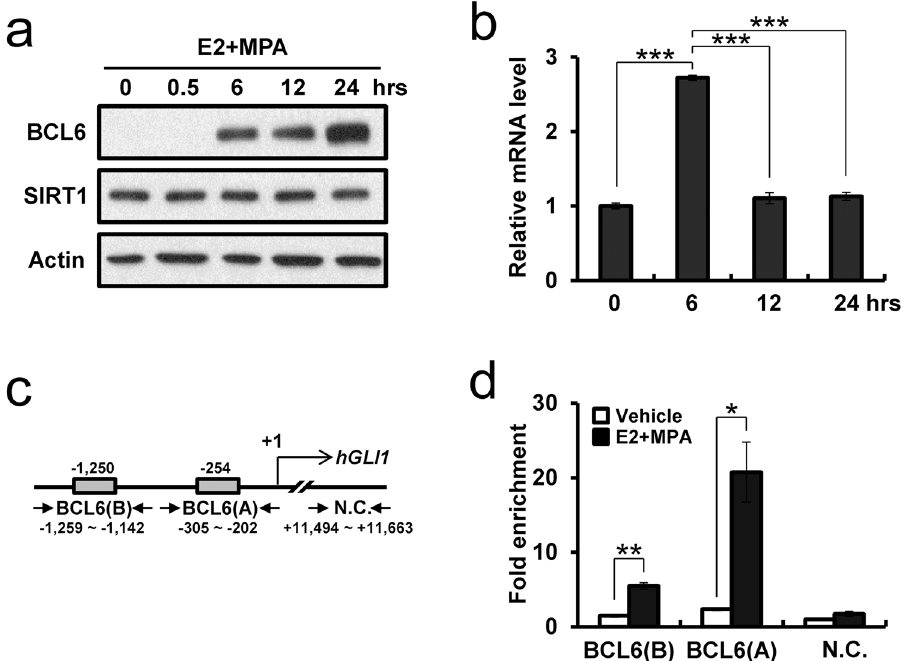
Figure 6. Regulation of GLI1 gene expression by SIRT1 and BCL6 proteins. ( a ) Western blot analysis of BCL6 and SIRT1 in Ishikawa cells treated with E2 + MPA for 0, 30 min, 6, 12, and 24 hours. β -actin was used as sample-loading control. Representative blots have been cropped to reduce unnecessary area. Full-length blots are presented in Supplementary Fig. S5. ( b ) Quantitative real time PCR analysis of GLI1 gene expression in Ishikawa cells treated with E2 + MPA for 0, 6, 12, and 24 hours. ( c ) Map of BCL6 binding site on the GLI1 promoter (Gray boxes). Negative control (N.C.) region on the GLI1 gene was used as negative control of ChIP assay. Primers used in ChIP assay are presented by arrows. ( d ) ChIP assay using anti-SIRT1 antibody on GLI1 promoter in Ishikawa cells treated with or without E2 + MPA for 24 hours. The results represent the mean ± SEM. * p < 0.05, ** p < 0.01, and *** p <